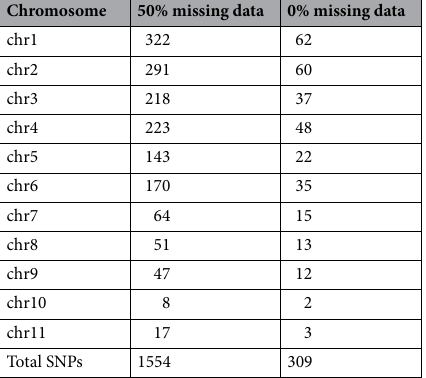
Table 2. The number of SNPs obtained from the reference-based assembly of 78 samples of Sceloporus occidentalis from the Puget Sound Region. Allowing for more missing data (50%) results in more SNPs compared to no missing data